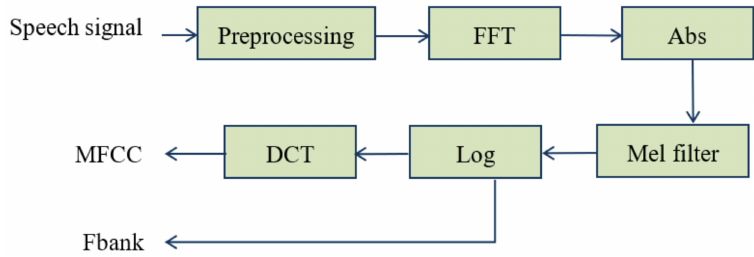
Figure 2. Extraction process of MFCC and